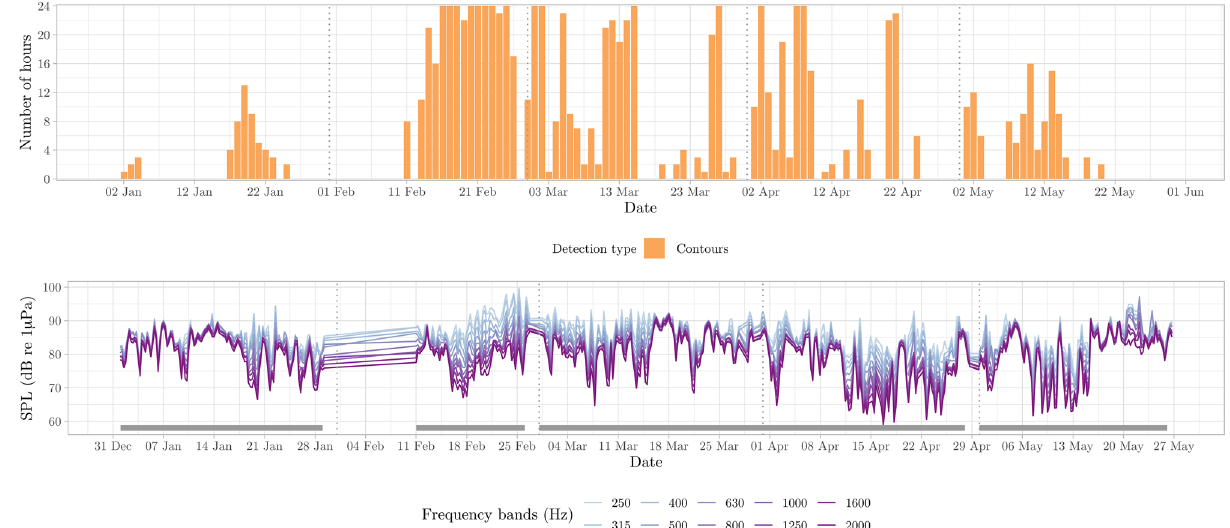
Figure 7. Number of detection hours per day for frequencies between 200 Hz and 2 kHz, with contour detections representing modulated signals of humpback whales and odontocetes (top). Sound Pressure Level values for different 1/3 octave bands, grouped into 6-hour averages for visibility purposes (bottom). Grey segment bars indicate the sampling effort in days (i.e., gaps represent lack of acoustic data).